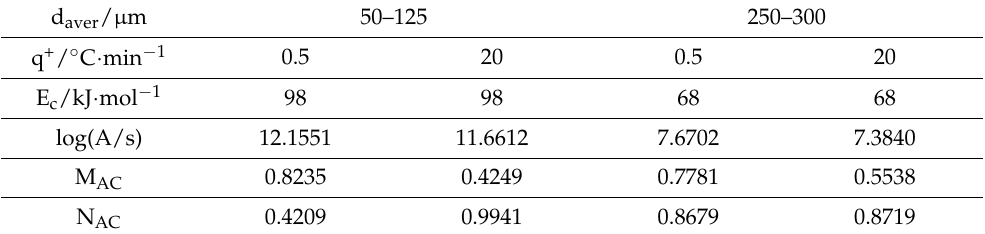
Table 1. Kinetic parameters determined by the sc-MKA method from the selected nonisothermal DSC data obtained for given values of d aver and q +